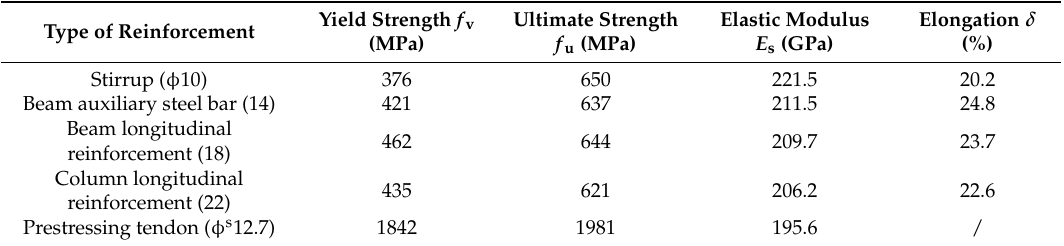
Table 2. Reinforcement material properties.